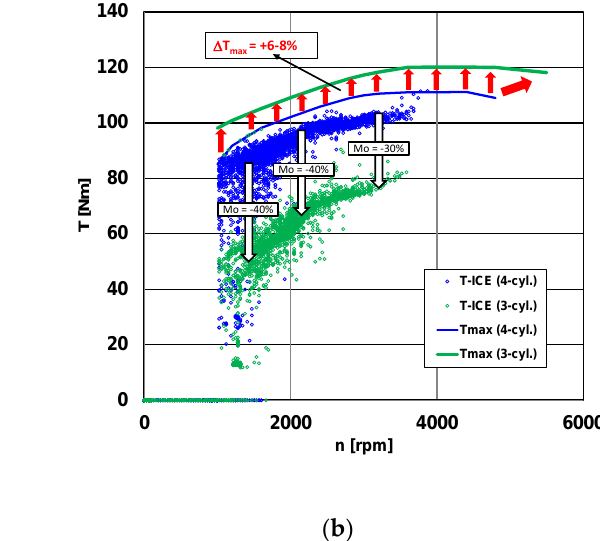
Figure 7. Operating conditions of the combustion engine: ( a ) density characteristics of both generations of combustion engines; ( b ) PV diagram of the combustion engines and their use.